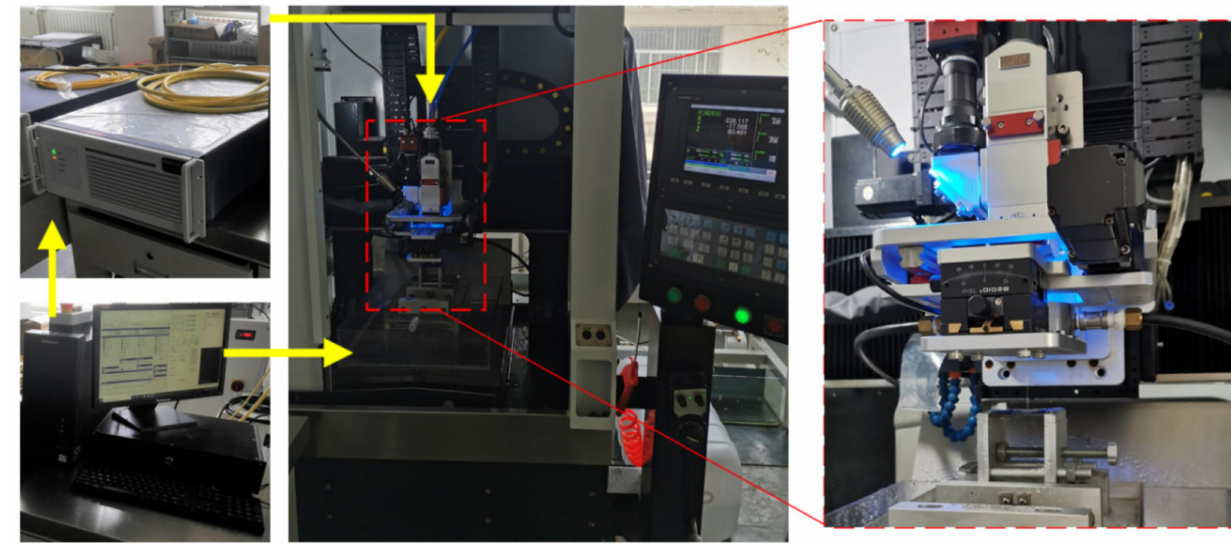
Figure 2. Schematic diagram of water jet-guided quasi-continuous laser cleaning